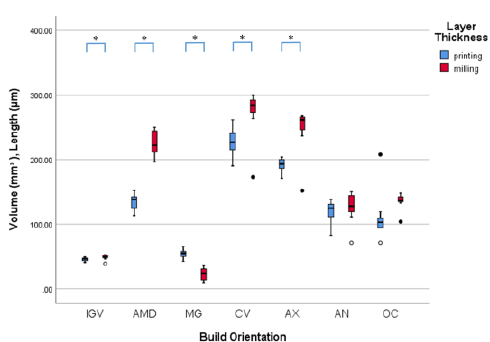
Figure 7. The internal gap volume (mm 3 ), marginal fit and internal gap length ( µ m) of the selected 3D printing and the milling prostheses. * indicate statistical significance between the selected 3D printing group and the milling group.